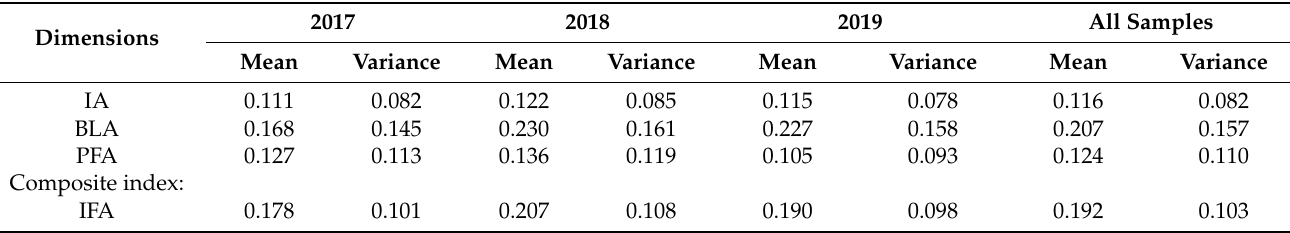
Table 6. Results of the rural households’ financial availability index.